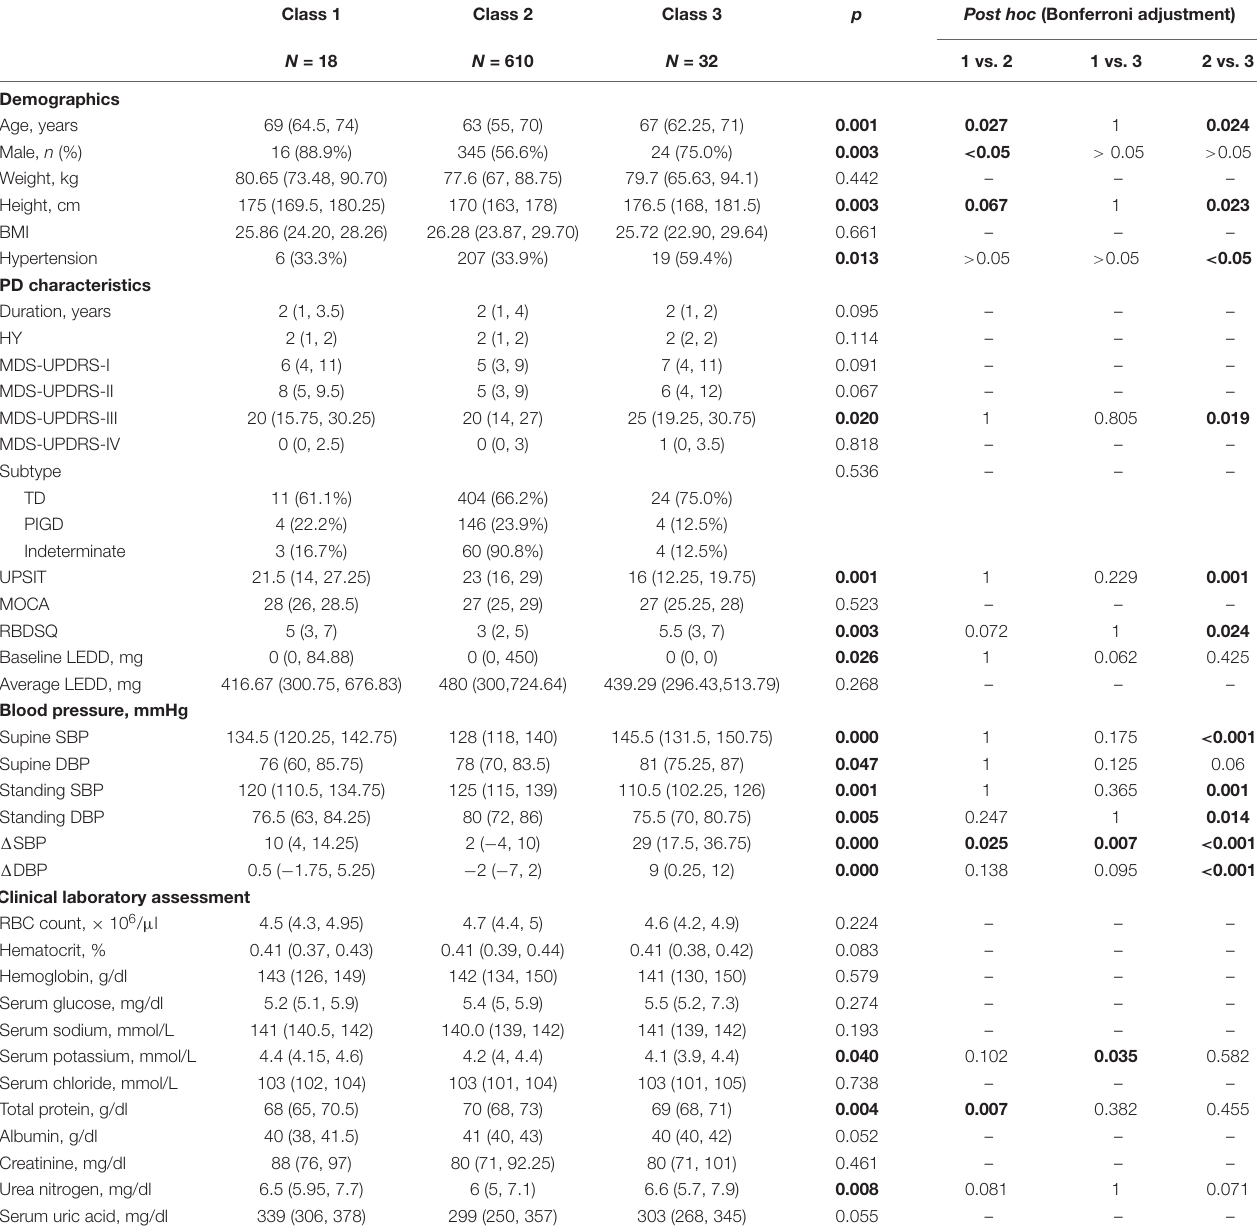
TABLE 2 | Characteristics of the study population by orthostatic systolic blood pressure change ( (cid:49) SBP) trajectory